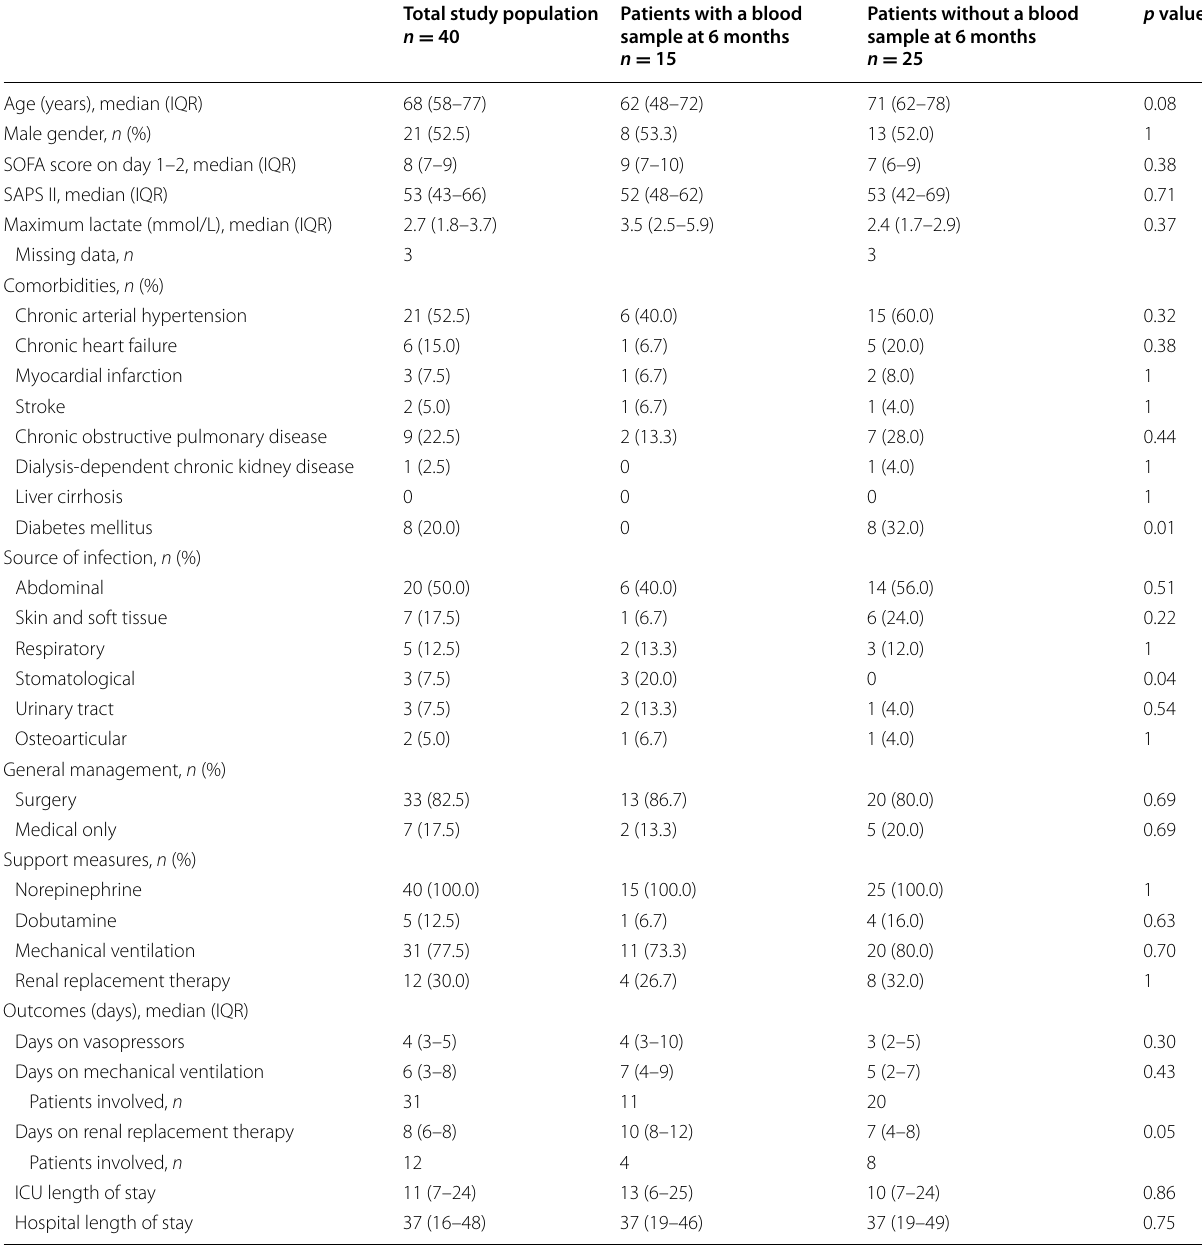
Table 1 Patient